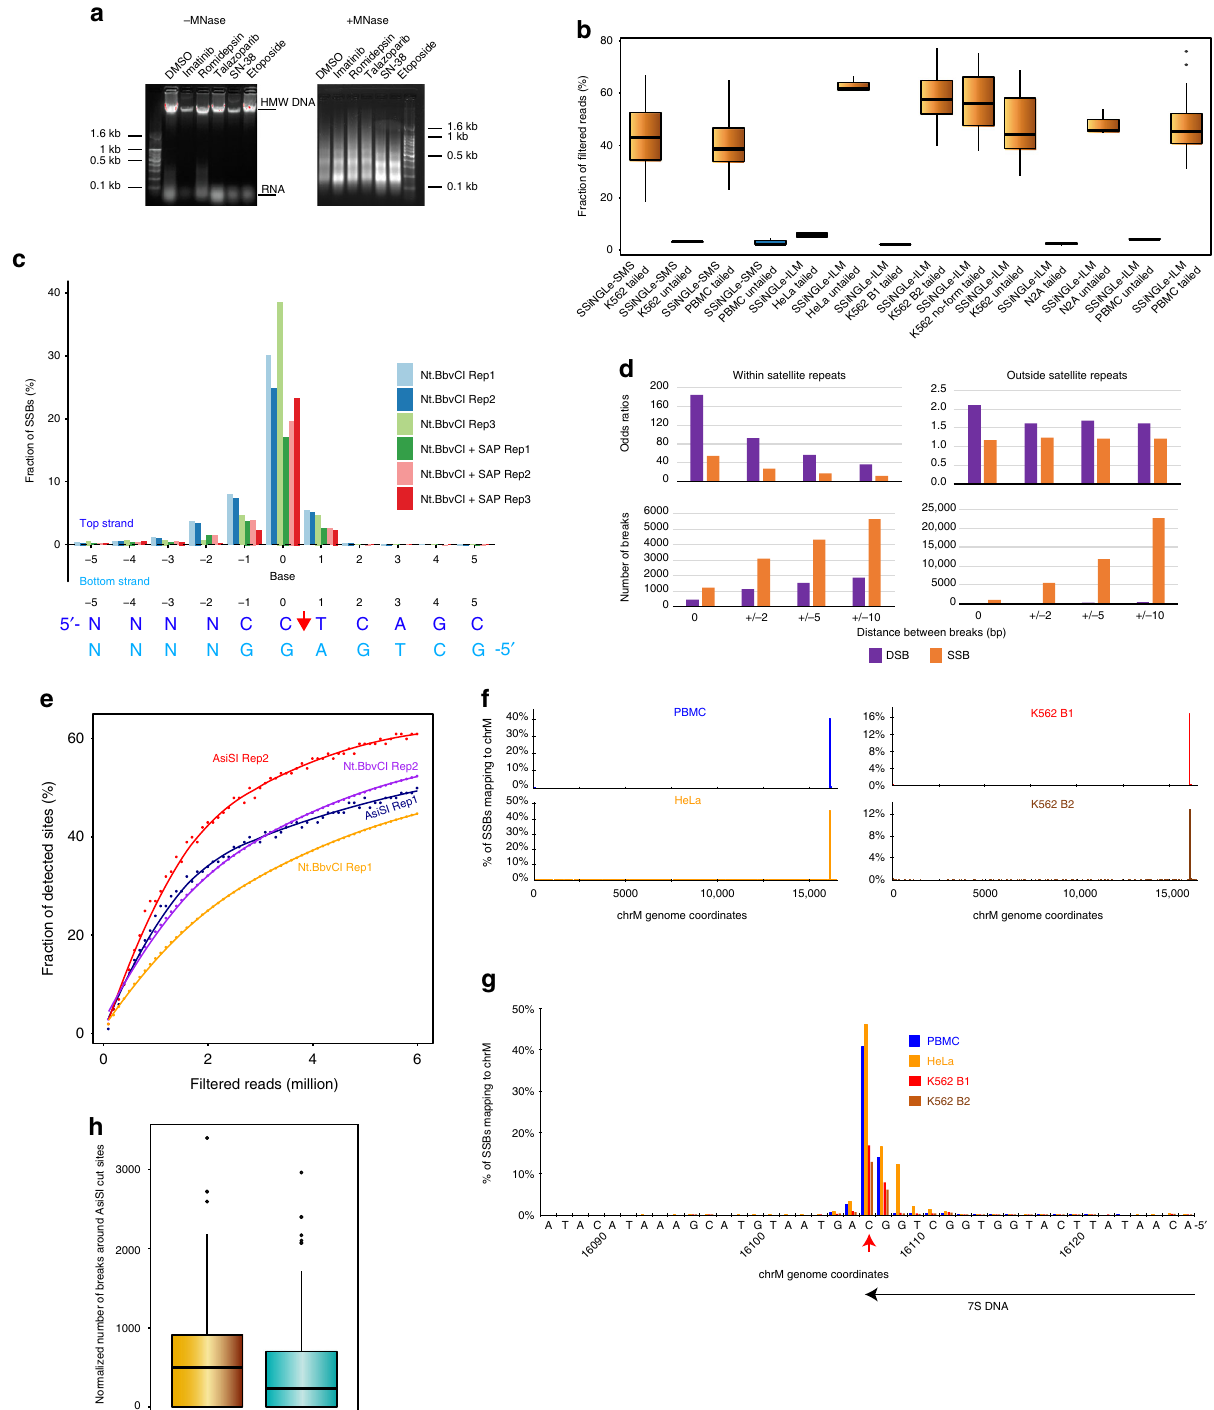
accurately detect endogenous SSBs with nucleotide-level resolu- tion. Second, we generated stable K562 cell line expressing doxycycline (Dox) inducible nuclear-targeted AsiSI endonuclease. Comparison of multiple + Dox vs − Dox samples revealed 1.27- fold enrichment of breaks within ±10 bp window from the expected cut sites the + Dox samples with p -value 0.008 (Wilcoxon signed-rank test) (Fig. 2h, Supplementary Data 4, Supplementary Note 1) suggesting that our method can indeed detect rare endogenous